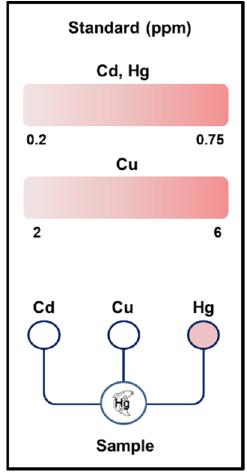
Figure A2. Product design of colorimetric metal sensor.